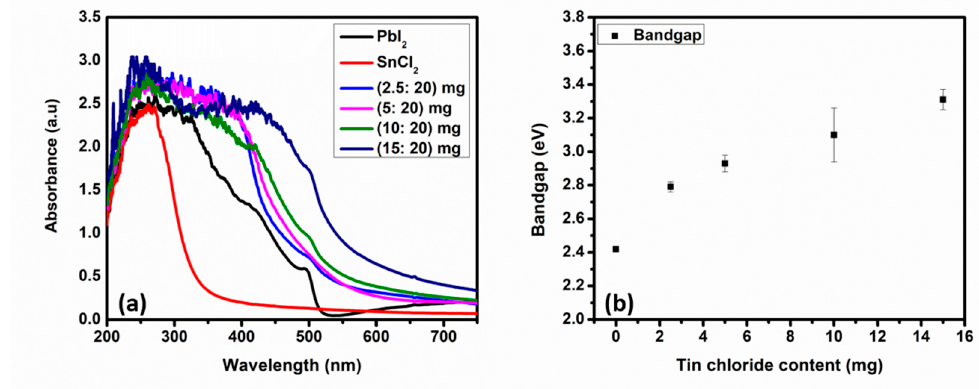
Figure 4. ( a ) The UV-Vis absorption spectra and ( b ) the E g evolution plot upon addition of the different amount of SnCl 2 .